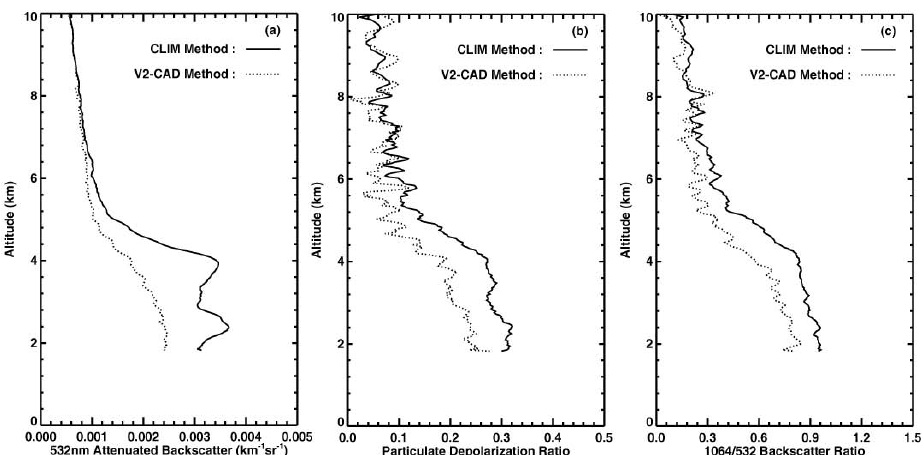
Fig. 11. Mean vertical profiles of dust aerosols over Taklamakan Desert using (a) 532-nm backscatter attenuated coefficients, (b) particulate depolarization ratio, and (c) 1064/532-nm backscatter ratio by V2-CAD method (dotted line), and CLIM (solid line) over Taklamakan Desert for elevationa below 3km during spring